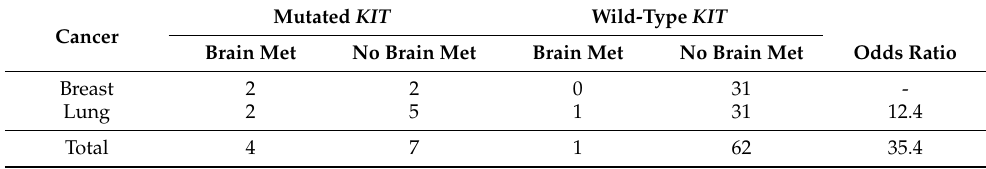
Table 5. Odds Ratio of KIT Mutation and Brain Metastasis in Breast and Lung Cancer